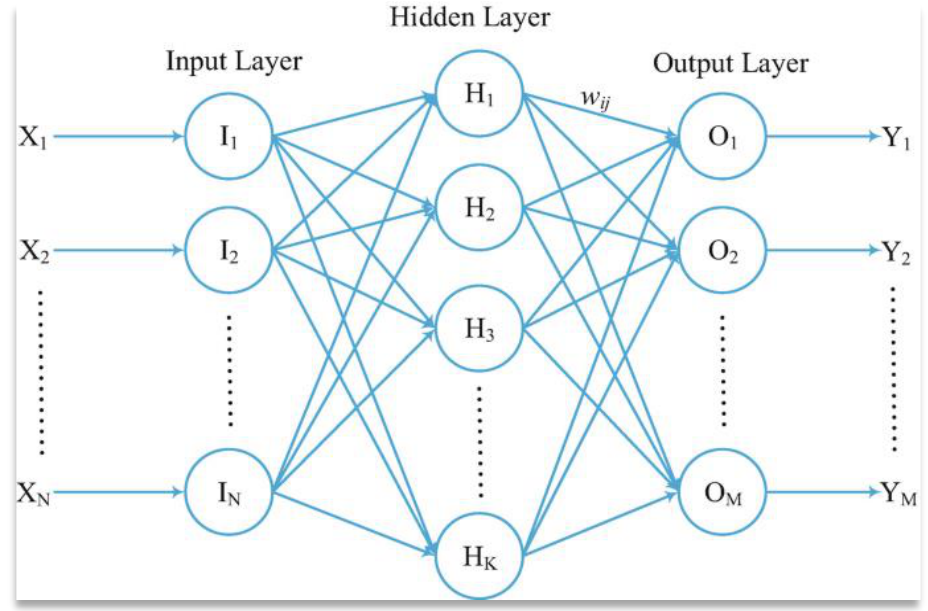
Figure 4. An example of a complex neural network flowchart.